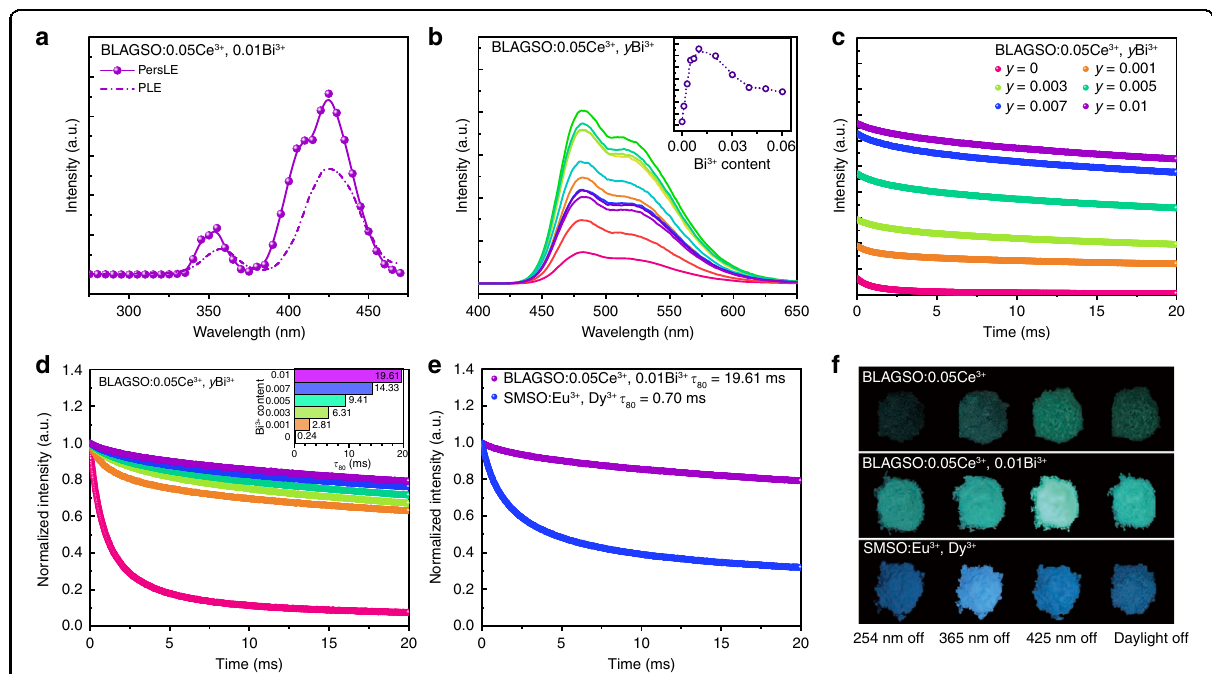
Fig. 5 Persistent luminescence properties. a PersLE and PLE spectra of BLAGSO:0.05Ce 3 + , 0.01Bi 3 + . b PersL spectra of BLAGSO:0.05Ce 3 + , y Bi 3 + . Inset: the PersL intensity of BLAGSO:0.05Ce 3 + , y Bi 3 + . c PersL decay curves of BLAGSO:0.05Ce 3 + , y Bi 3 + . d Normalized PersL decay curves of BLAGSO:0.05Ce 3 + , y Bi 3 + . Inset: the values of τ 80 for BLAGSO:0.05Ce 3 + , y Bi 3 + . e Normalized PersL decay curves of BLAGSO:0.05Ce 3 + , 0.01Bi 3 + and SMSO:Eu 2 + , Dy 3 + . f PersL photographs of BLAGSO:0.05Ce 3 + , BLAGSO:0.05Ce 3 + , 0.01Bi 3 + , and SMSO:Eu 2 + , Dy 3 + after excitation at 254, 365, 425 nm, and daylight,